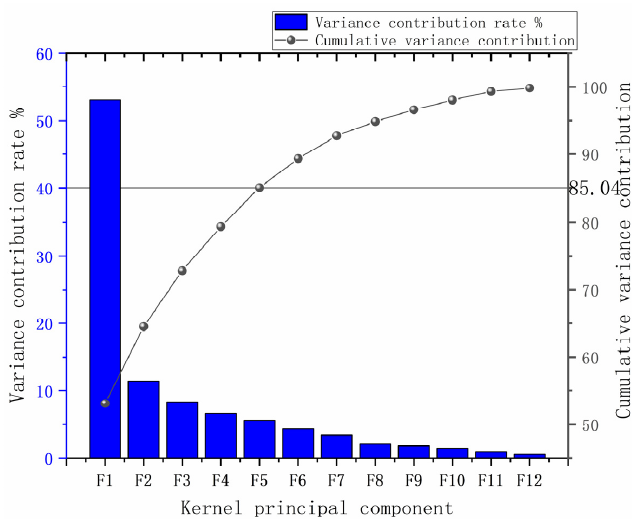
Figure 4. Cumulative contribution rate.